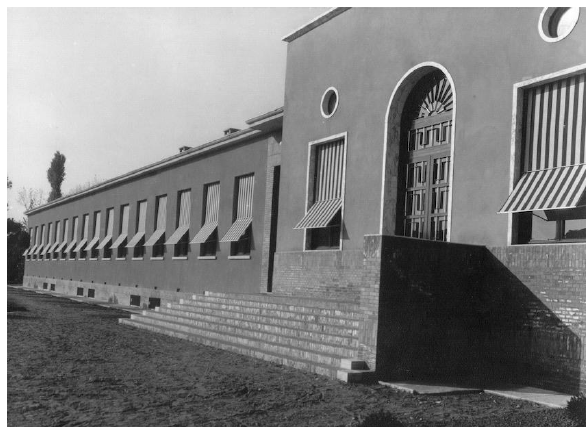
Figure 1. Santarelli kindergarten. © Biblioteca Comunale “Aurelio Saffi” di Forlì, Archivio Santarelli , album fotografico 2 “Asilo Infantile ‘Santarelli’ Forlì.